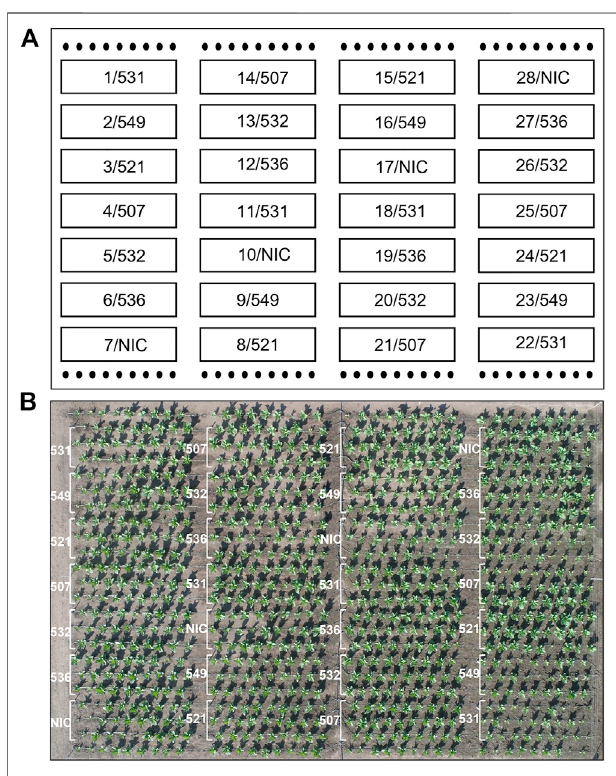
FIGURE 3 | Field trial plan: 4 repetitions for each event, 3 rows and 9 plants per plot. (A) schematic fi eld map; the numbers represent the plot and event; NIC plants as the border line. (B) Aerial image of the fi eld 23 days after planting. White bars: plot borders.